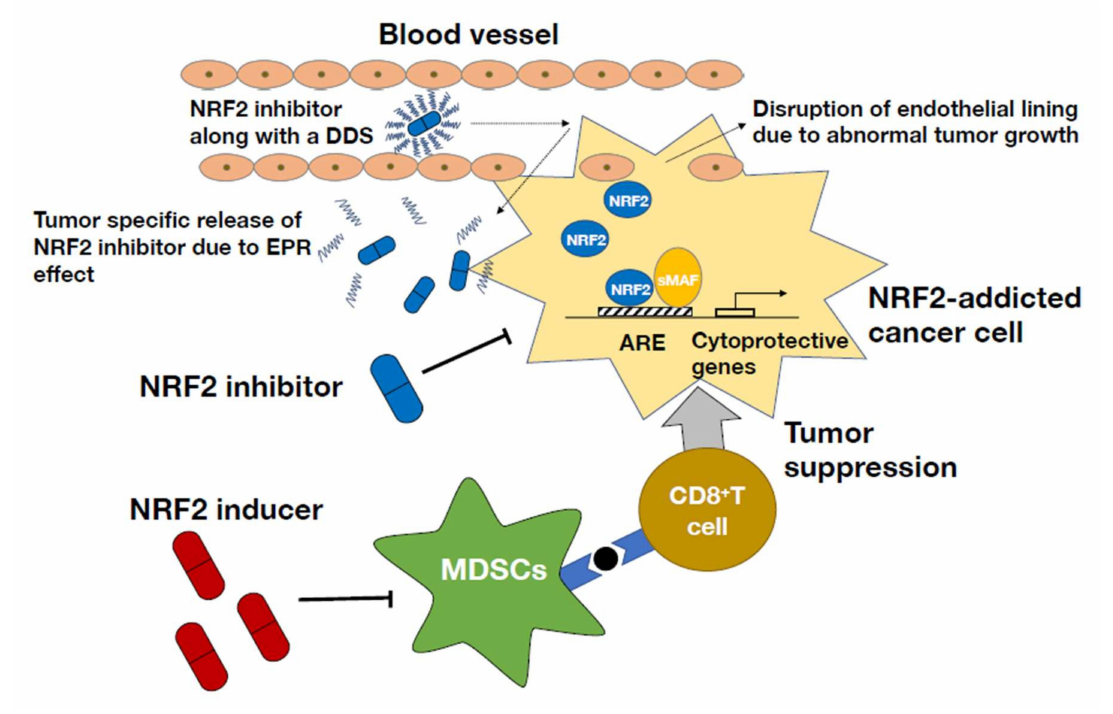
Figure 6. Therapeutic strategies to control NRF2-addicted cancers. NRF2 activation in myeloid- derived suppressor cells (MDSCs) leads to a decrease in reactive oxygen species (ROS) and IL-6 levels and contributes to the maintenance of CD8 + T cell activity. Hence, using NRF2 inducers in the tumor microenvironment is a rational approach to control NRF2-addicted cancer. In contrast, in the tumor itself, NRF2 inhibitors help suppress tumor growth and metastasis by decreasing NRF2 protein